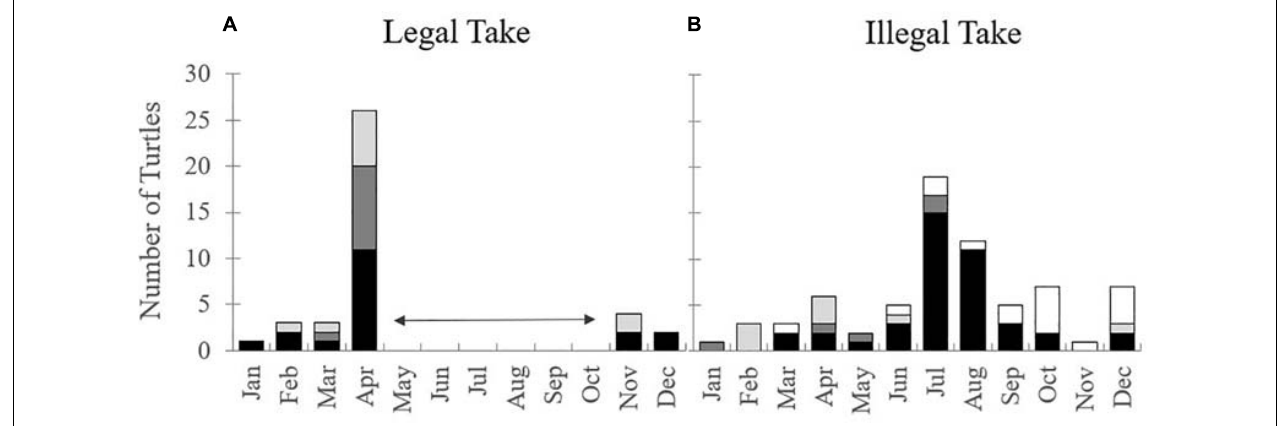
FIGURE 3 | Number of turtles harvested from the wild by month, legally (1999–2008) (A) and illegally (1999–2019) (B) . Bar colours represent different species (black: green turtles, dark grey: loggerhead turtles, light grey: hawksbill turtles, and white: unidentified species). Data reported is from all three Cayman Islands. Horizontal arrows represent the government imposed “no-take” season for licensed turtle